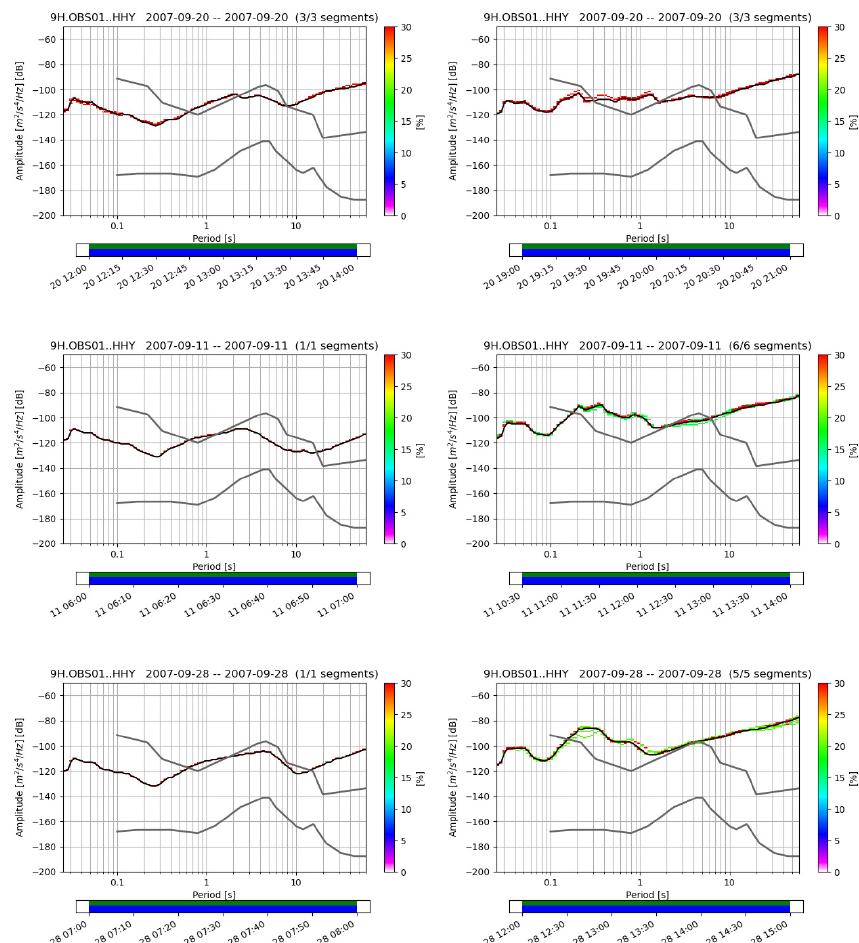
Figure 12. PPSD of 9H OBS01 for the spring and neap tides – on top, PPSD for the 20 September 2007 (first quarter moon neap tide with 0.7m tidal range), middle at 11 September 2007 (new moon spring tide with 2.8m tidal range) and on the bottom the 27 September 2007 (full moon spring tide with 3.5m tidal range). On the left, the seismometer response during laminar flow and, on the right, during turbulent